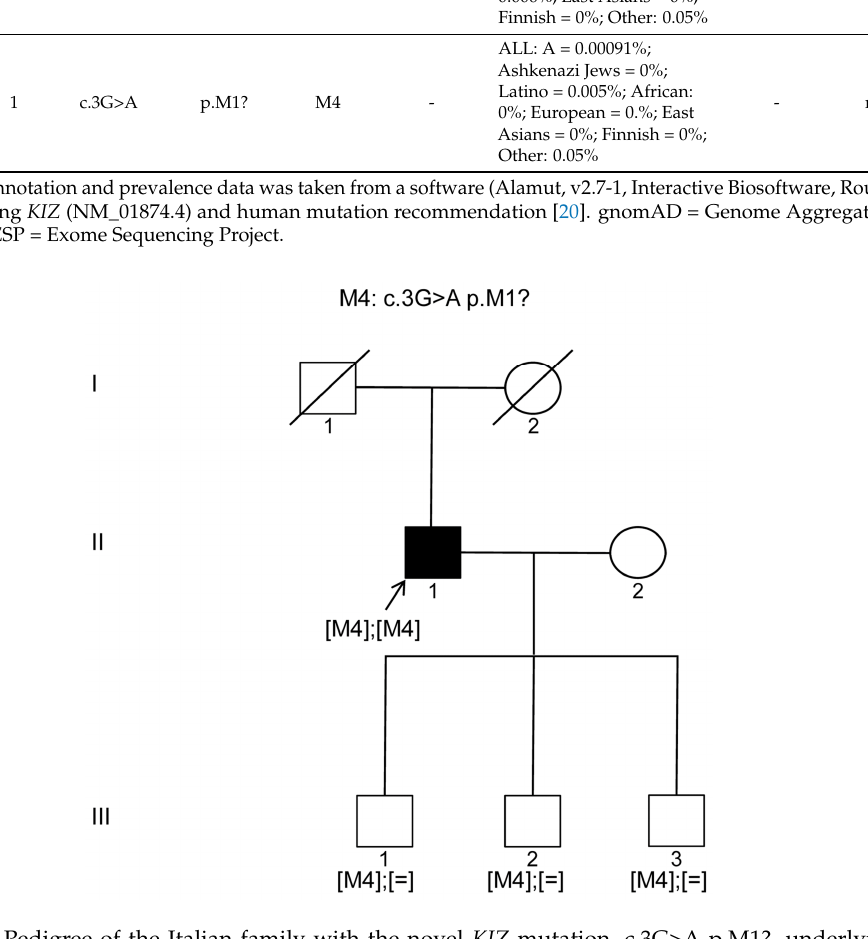
Table 1. Novel patients with rod ‐ cone dystrophy and KIZ mutations.